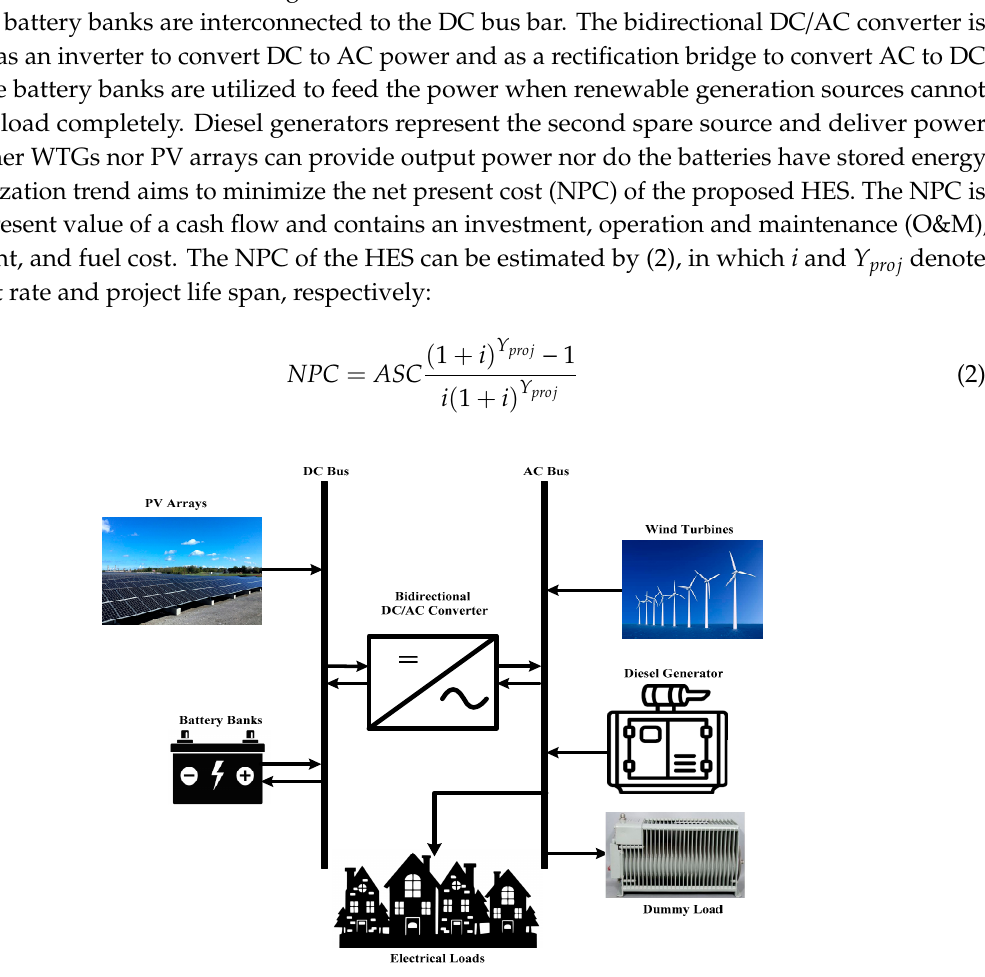
Table 1. Correlation coefficient of load, solar irradiance, and wind speed.